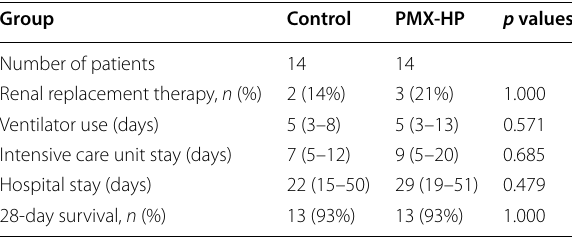
Data are presented as the number (%) or median (interquartile range)